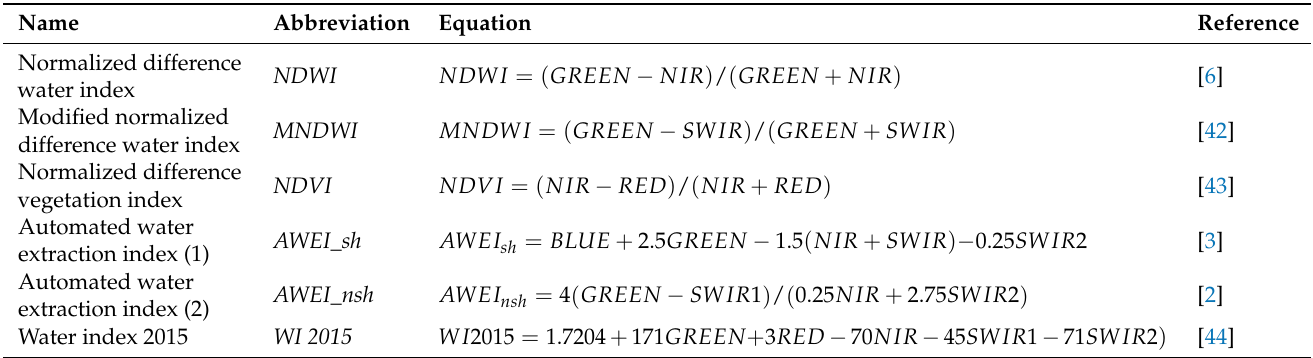
Table 2. Water indexes of the optical